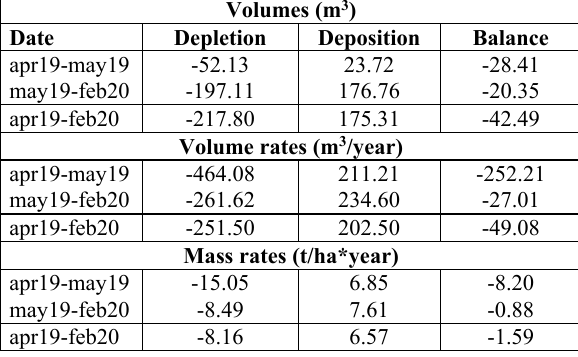
Table 6. Volumes in the gully